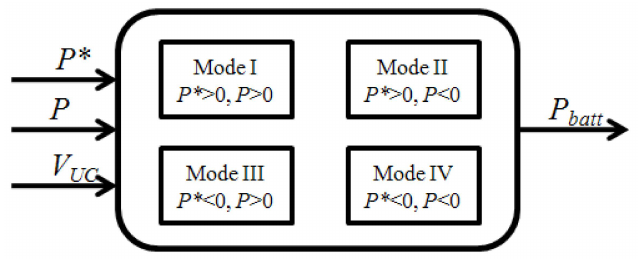
Figure 18. Four modes of the proposed strategy.